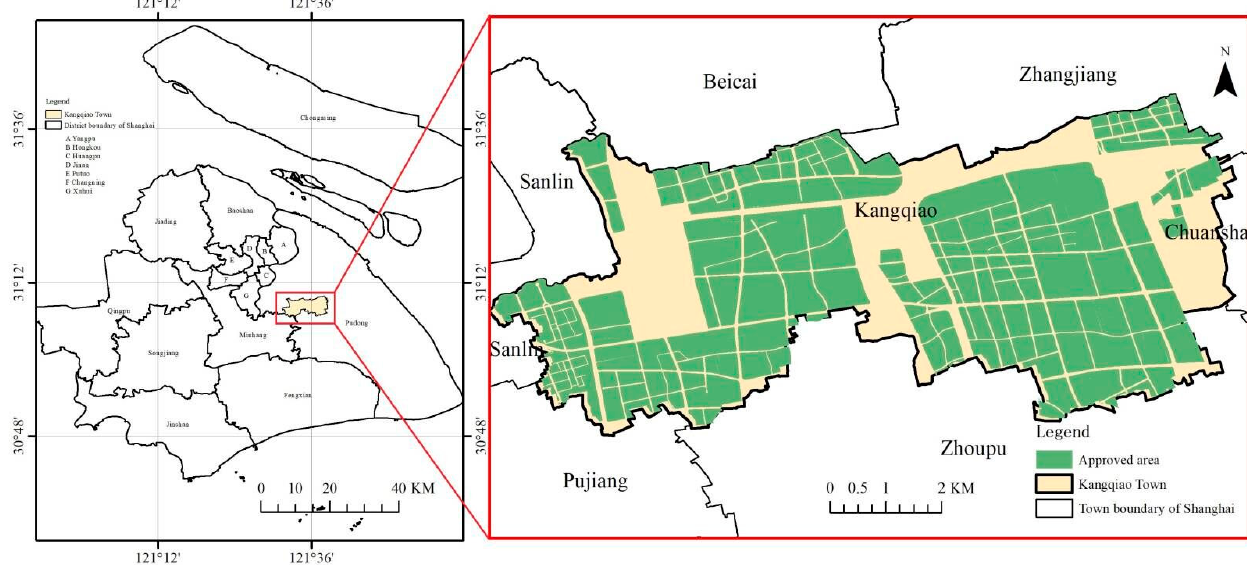
Figure 2. The location of the Kangqiao industrial park in Shanghai.